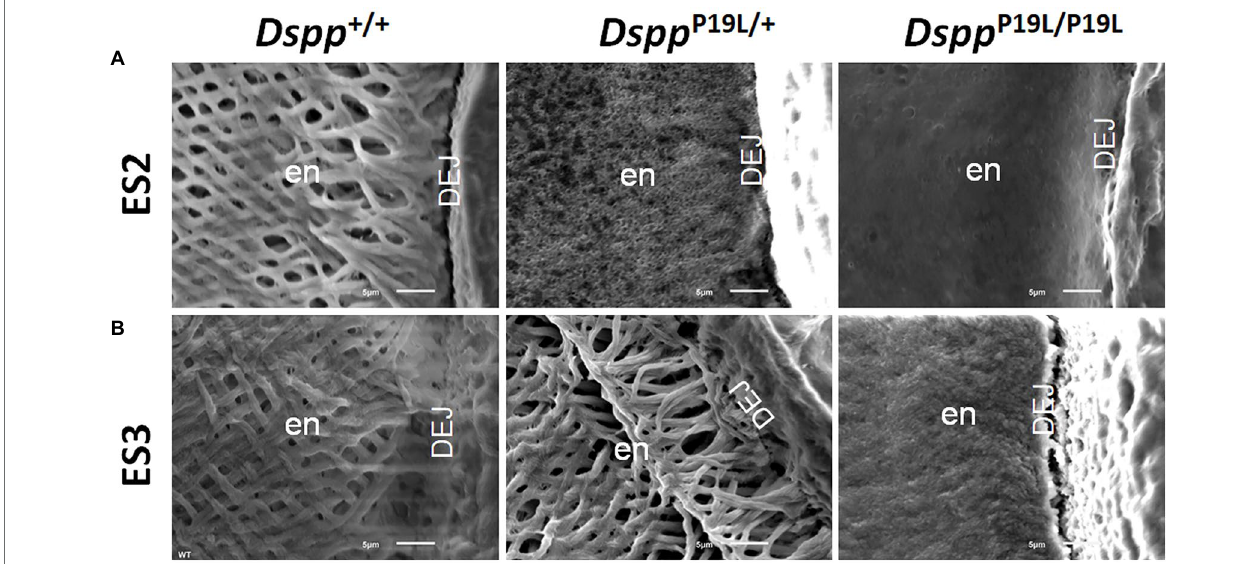
FIGURE 2 | Acid-etched scanning electron microscopy (SEM) analyses of the mandibular incisors. Shown are the acid-etched SEM images of the mandibular incisors of 7-week-old wild-type Dspp +/+ , heterozygous Dspp P19L/+ and homozygous Dspp P19L/P19L mice. All images are the cross sections obtained at the levels of ES2 (A) and ES3 (B) . Note that the enamel from Dspp +/+ mice showed decussating pattern of enamel rods at both ES2 and ES3 levels. In Dspp P19L/+ mouse incisors, even though only minute particulates were observed at the level of ES2, distinct decussating enamel rods were present at the level of ES3. In the Dspp P19L/P19L